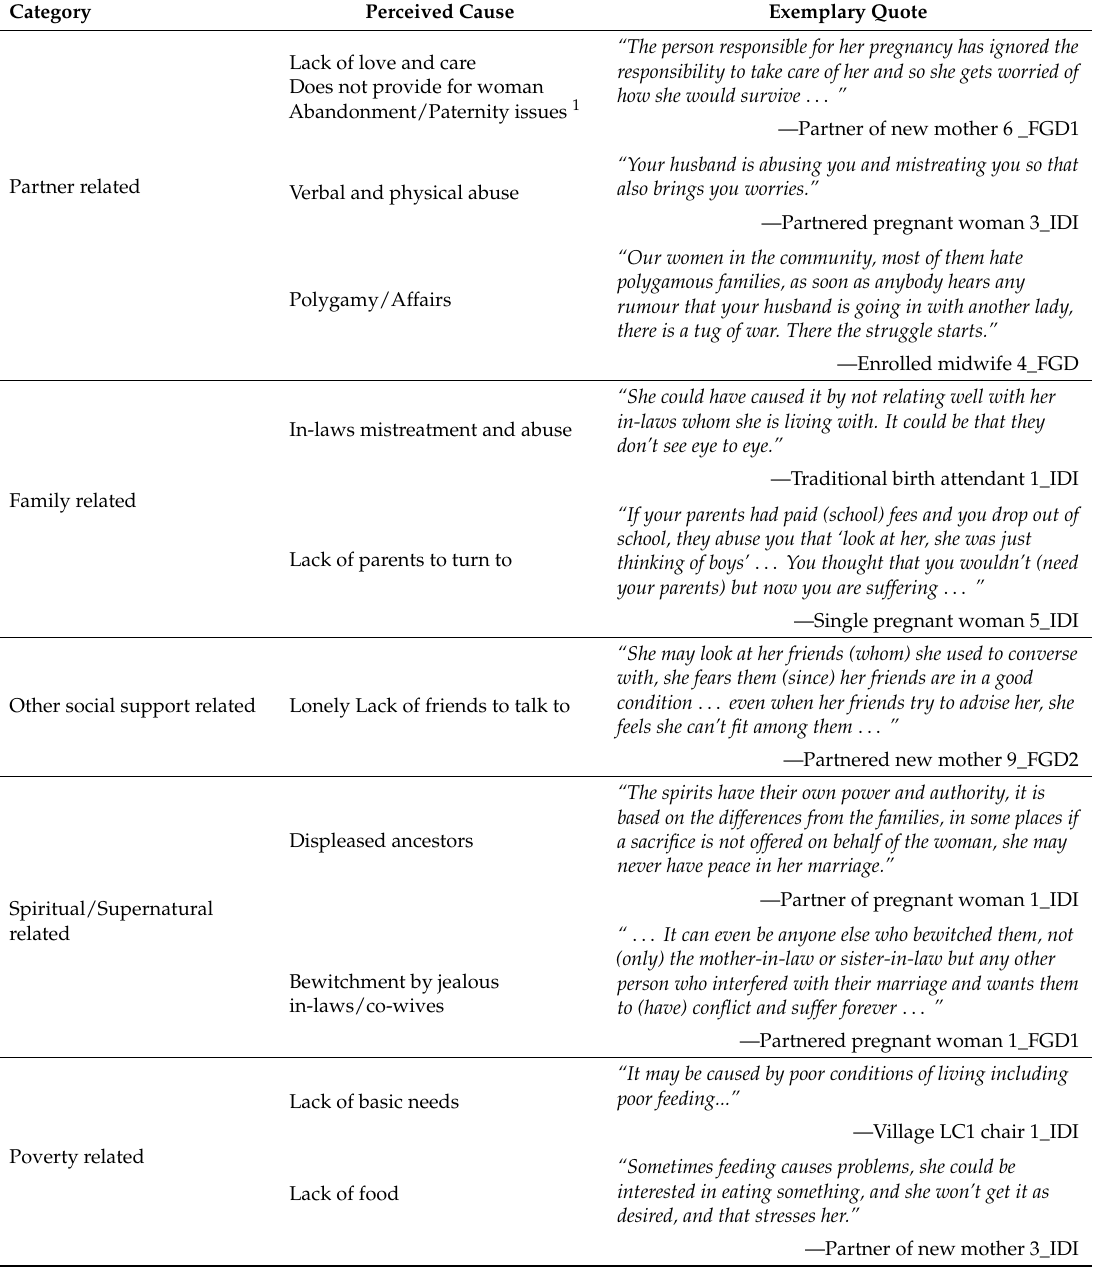
Table 4. Classification and examples of participants’ perceived causes of